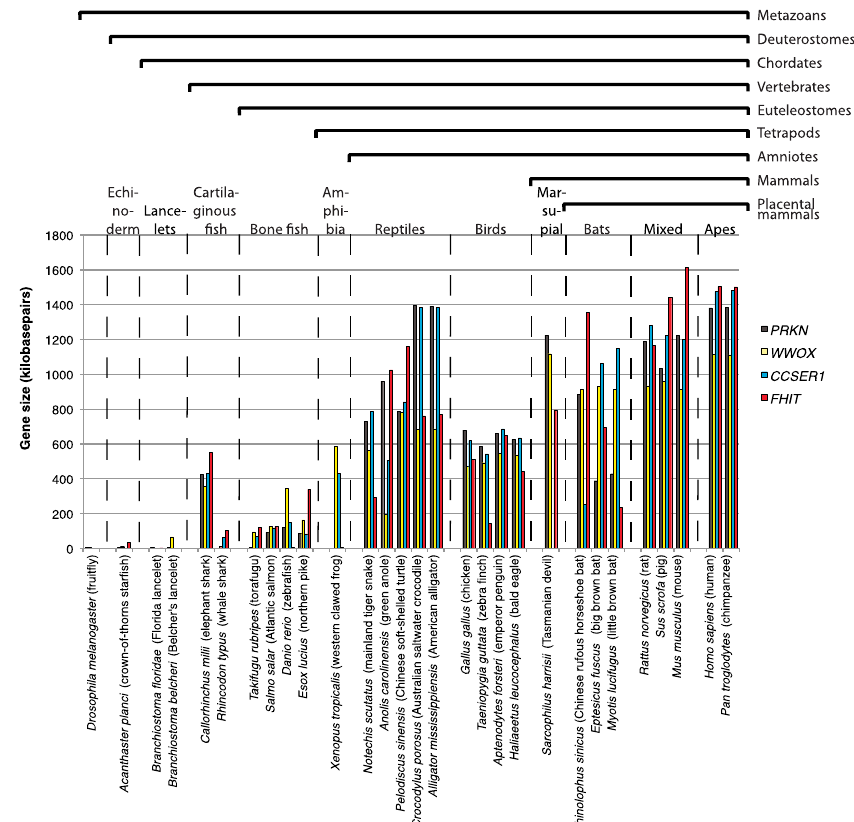
Figure 2. Bar chart showing gene sizes of the CFS genes PRKN , WWOX , CCSER1 , and FHIT in various metazoan species with focus on vertebrates. Latin name and common name is given below the bars. Phylogenetic classification is indicated above the chart. Gene sizes are retrieved from the National Center for Biotechnology Information (NCBI) genes database.